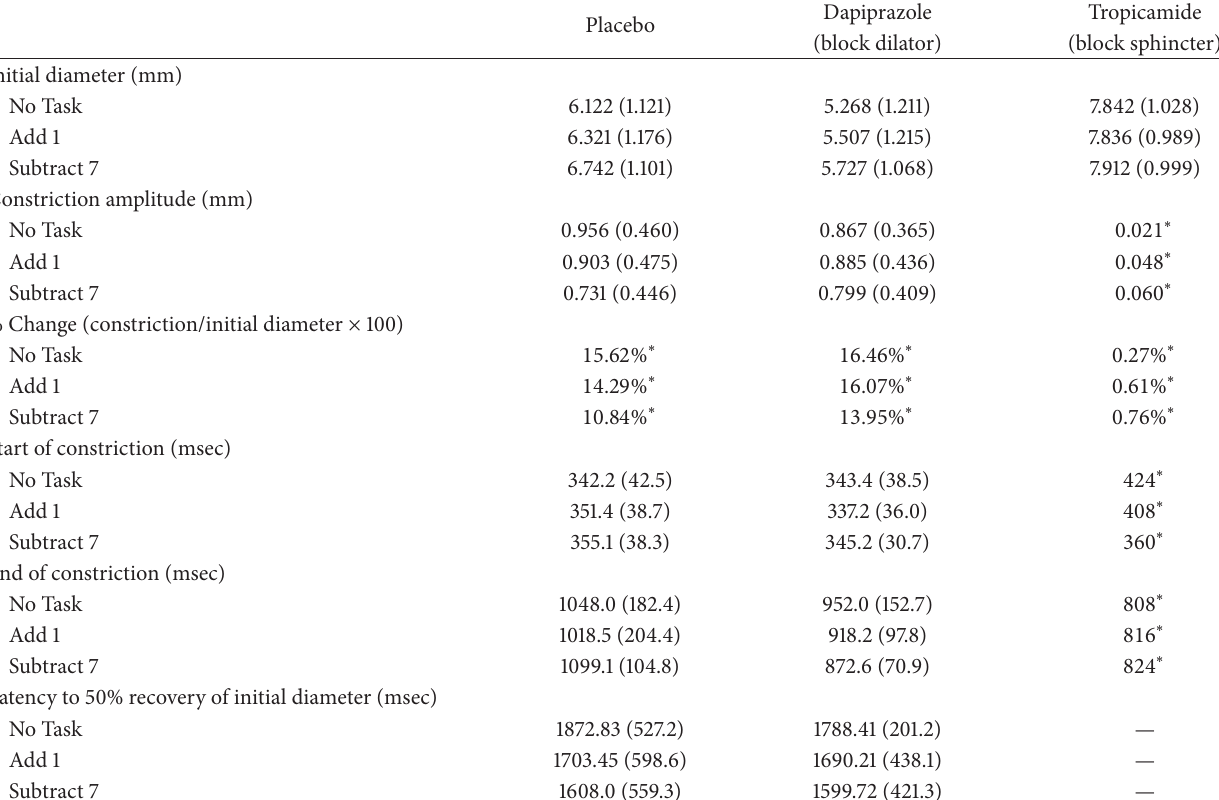
Table 1: Summary of pupillary measures [mean (standard deviation)] for placebo, dapiprazole, and tropicamide sessions as a function of task